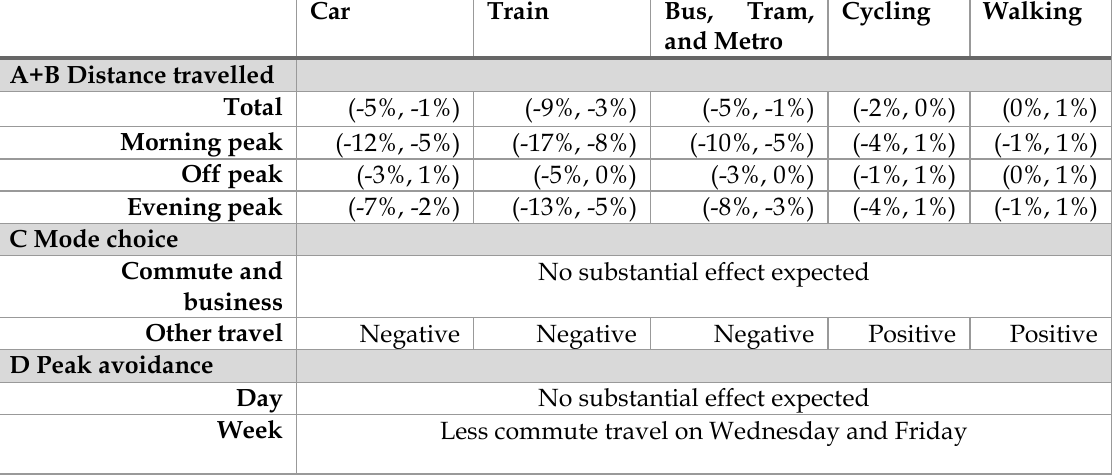
Table 1: Summary of all expected travel effects due to more working from home and teleconferencing Car Train Bus, Tram,